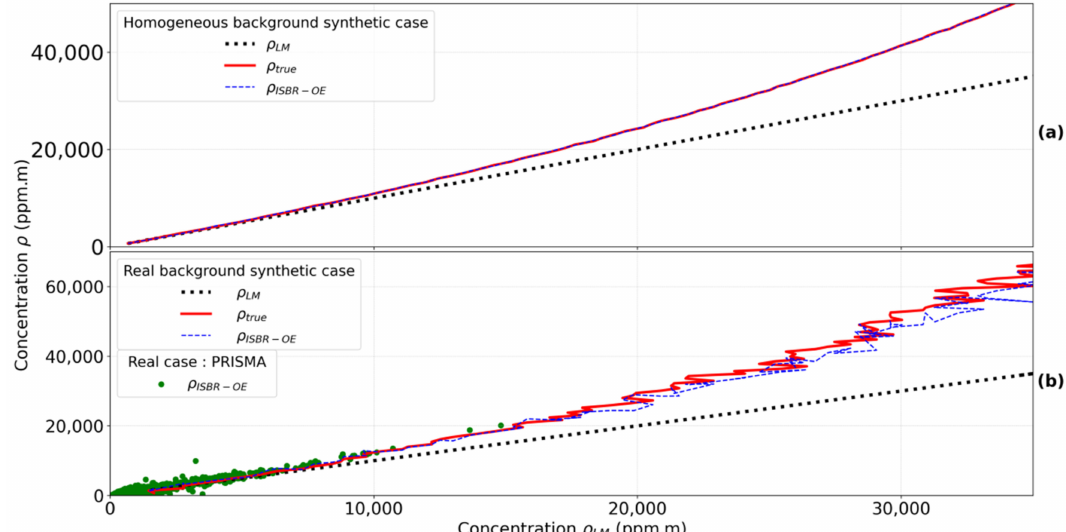
Figure 3. Plume concentration (synthetic in red and by ISBR-OEM in blue) as a function of the plume concentration obtained by LM. A noise brick reflectance map is used to compare the inversion method results to the synthetic ( a ); a real reflectance scene is used and the result of the inversion for a PRISMA image is plotted in green points ( b